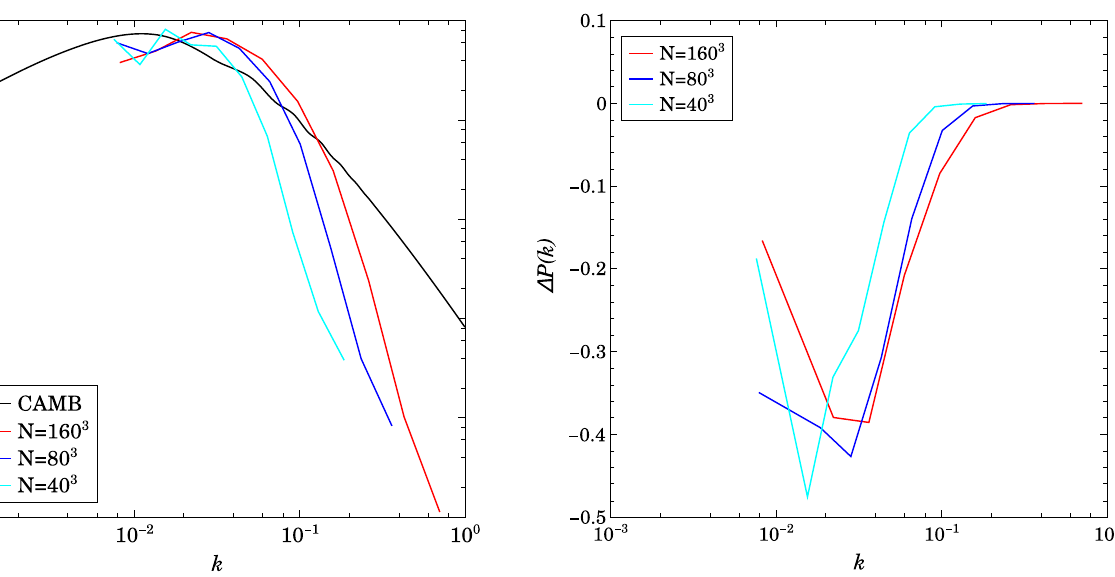
Fig. 4 Matter power spectra and the effects of tensor perturbations on spectra. The black curve in the left plot is the linear matter power spectrum at z + 1 = 1 produced by CAMB with parameters listed in Table 1; the red, blue and cyan curves in the left plot are the matter power spectra drawn from density perturbations δ( x i ) at a S = 1090 by the function power_spectrum_1d in c2raytools at 160 3 , 80 3 and 40 3 resolution respectively, where δ( x i ) is given by simulations with only scalar perturbations. It’s worth pointing out that although, at the